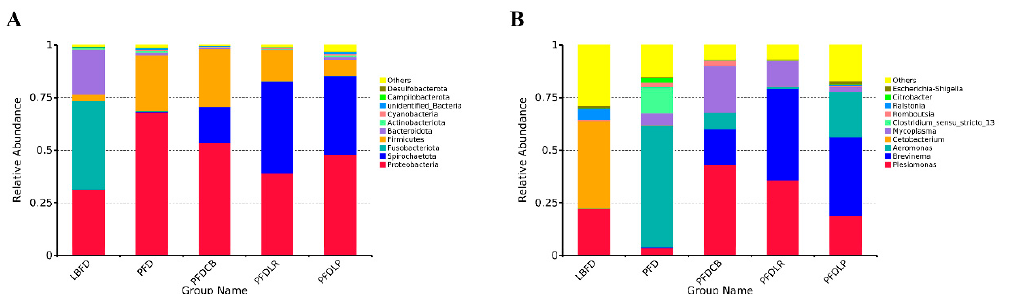
Figure 9. The abundance of composition at phylum ( A ) and genus ( B ) level in mandarin fish intestinal microbial populations in different feeding groups (LBFD, PFD, PFDCB, PFDLR and PFDLP) after being fed for 28 days. Abbreviations: LBFD, live bait fish feeding group; PFD, pellet-feed feeding group with probiotics free; PFDCB, pellet-feed feeding group with C. butyricum plus; PFDLR, pellet-feed feeding group with L. rhamnosus plus; PFDLP, pellet-feed feeding group with L. plantarum plus.